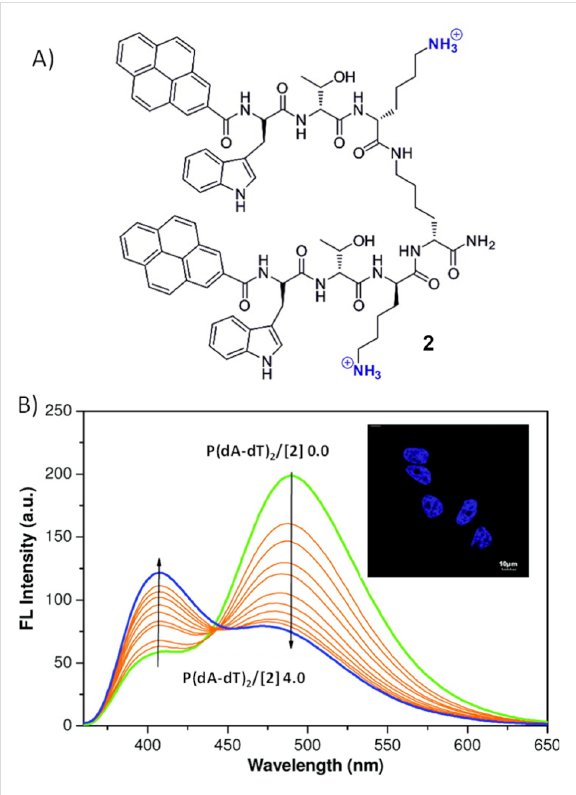
Figure 3: A) Molecular structure of probe 2 ; B) fluorescence emission spectra for the titration of a 10 μ M solution of 2 with p(dA·dT) 2 in aqueous buffer (pH 7.4) (with base pair/ 2 molar ratios ranging from 0 to 4.0), inset: nuclei of HeLa cells stained with 2 . Reprinted with permission from [34]. Copyright (2012) American Chemical Society.